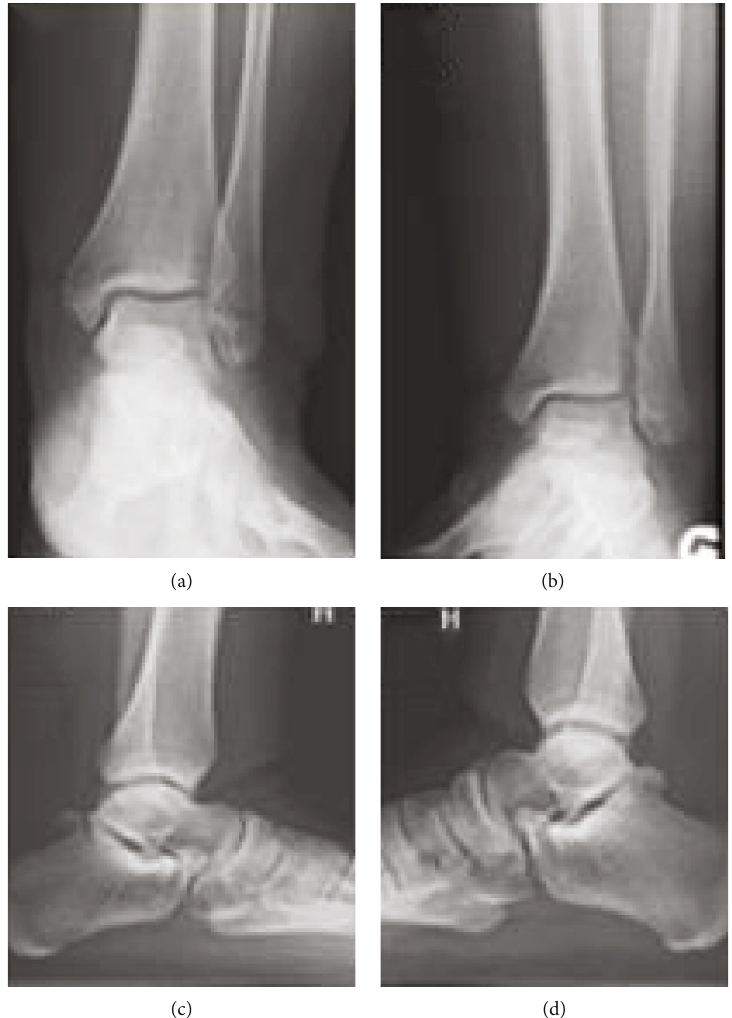
Figure 4: (a) AP view of the left ankle demonstrating mild medial tibial and talar osteophyte formation. (b) Mortise view of the left ankle again demonstrating medial osteophyte formation. (c) Lateral view of the left ankle demonstrating anterior tibial osteophyte formation and mild narrowing with mildly displaced os trigonum. (d) Lateral view of right ankle demonstrating nondisplaced os